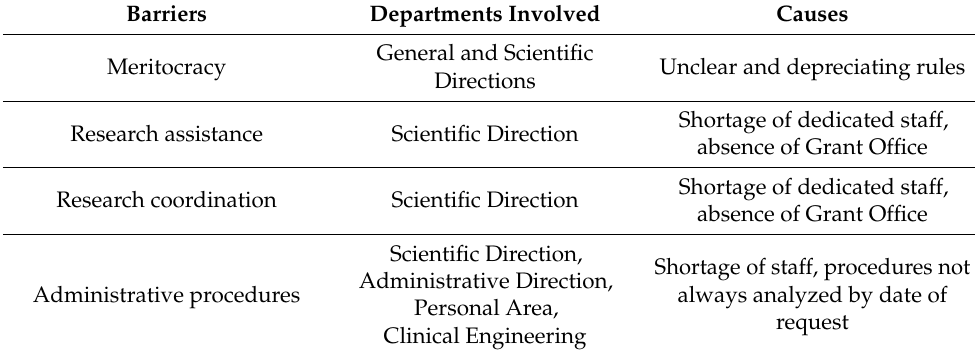
Table 2. Principal barriers and main causes